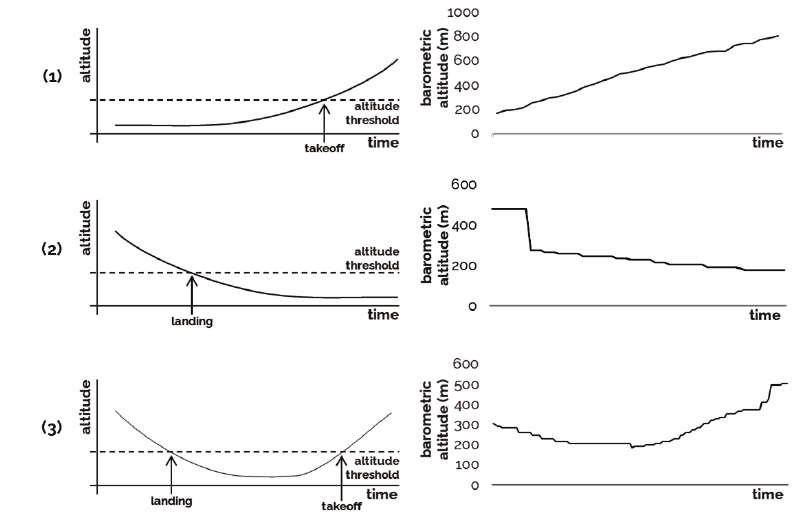
Figure 3. Th ere are three operational scenarios that we need to account for in detection algorithms. Th e aircraft can (1) start its fl ight track on the ground and become airborne, (2) start airborne and land, or (3) takeoff and land in the same track, i.e. a touch and go. We defi ne a fl ight track in the context of this algorithm as the period from the fi rst time the aircraft is detected in the boundary box to the time it departed the boundary box or landed. Th e real fl ights (1) and (2) on the right are from TUL, and (3) is from LAF. Th ese real fl ight examples also showcase some of the